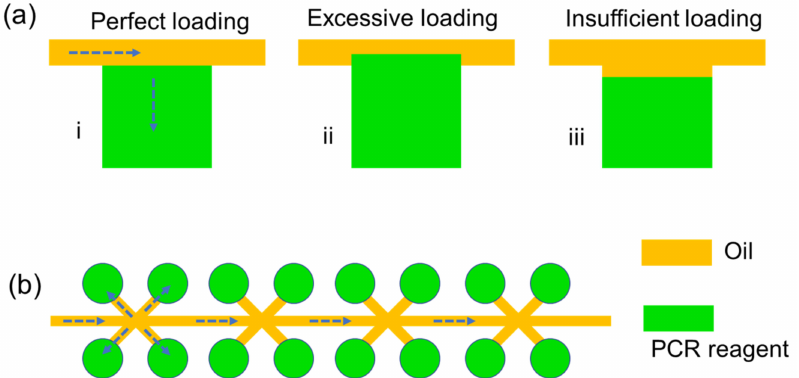
Figure 5. Schematic of chamber array-based dPCR microfluidic chip. ( a ) Cross-section view of two-layer lithography fabricated PDMS layer, including a pilot channel filled with oil, and a group of micro chambers filled with PCR reagents; left: the case of perfect sample loading; middle: the case of excessive sample loading; right: the case of insufficient sample loading. ( b ) Top view of two-layer lithography fabricated PDMS channel or single-layer lithography fabricated PDMS